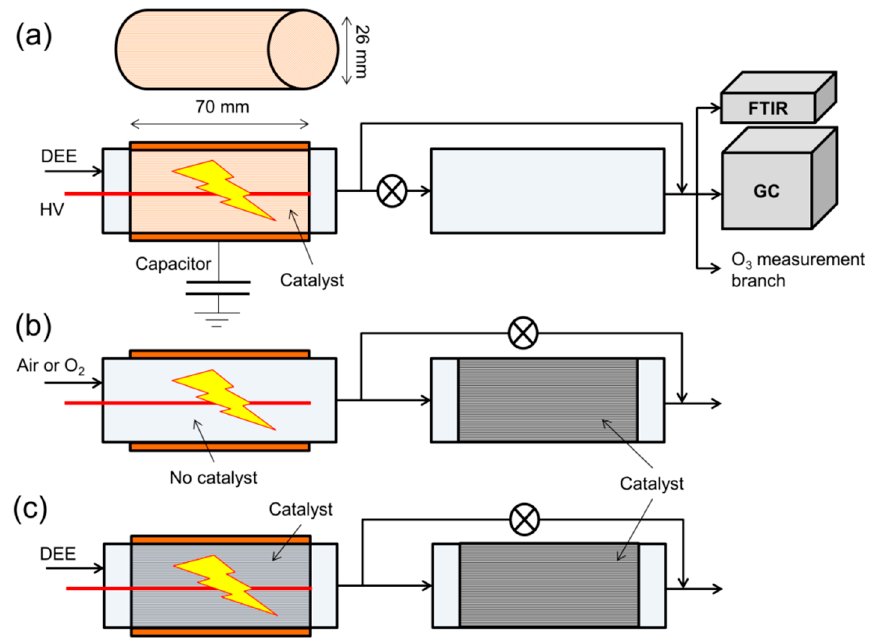
Figure 11. Experimental reactor system. ( a ) One-stage reactor for DEE decomposition, ( b ) Reactor for investigating ozone decomposition on different catalysts and ( c ) Hybrid Mn+(Mn-Fe) reactor for DEE